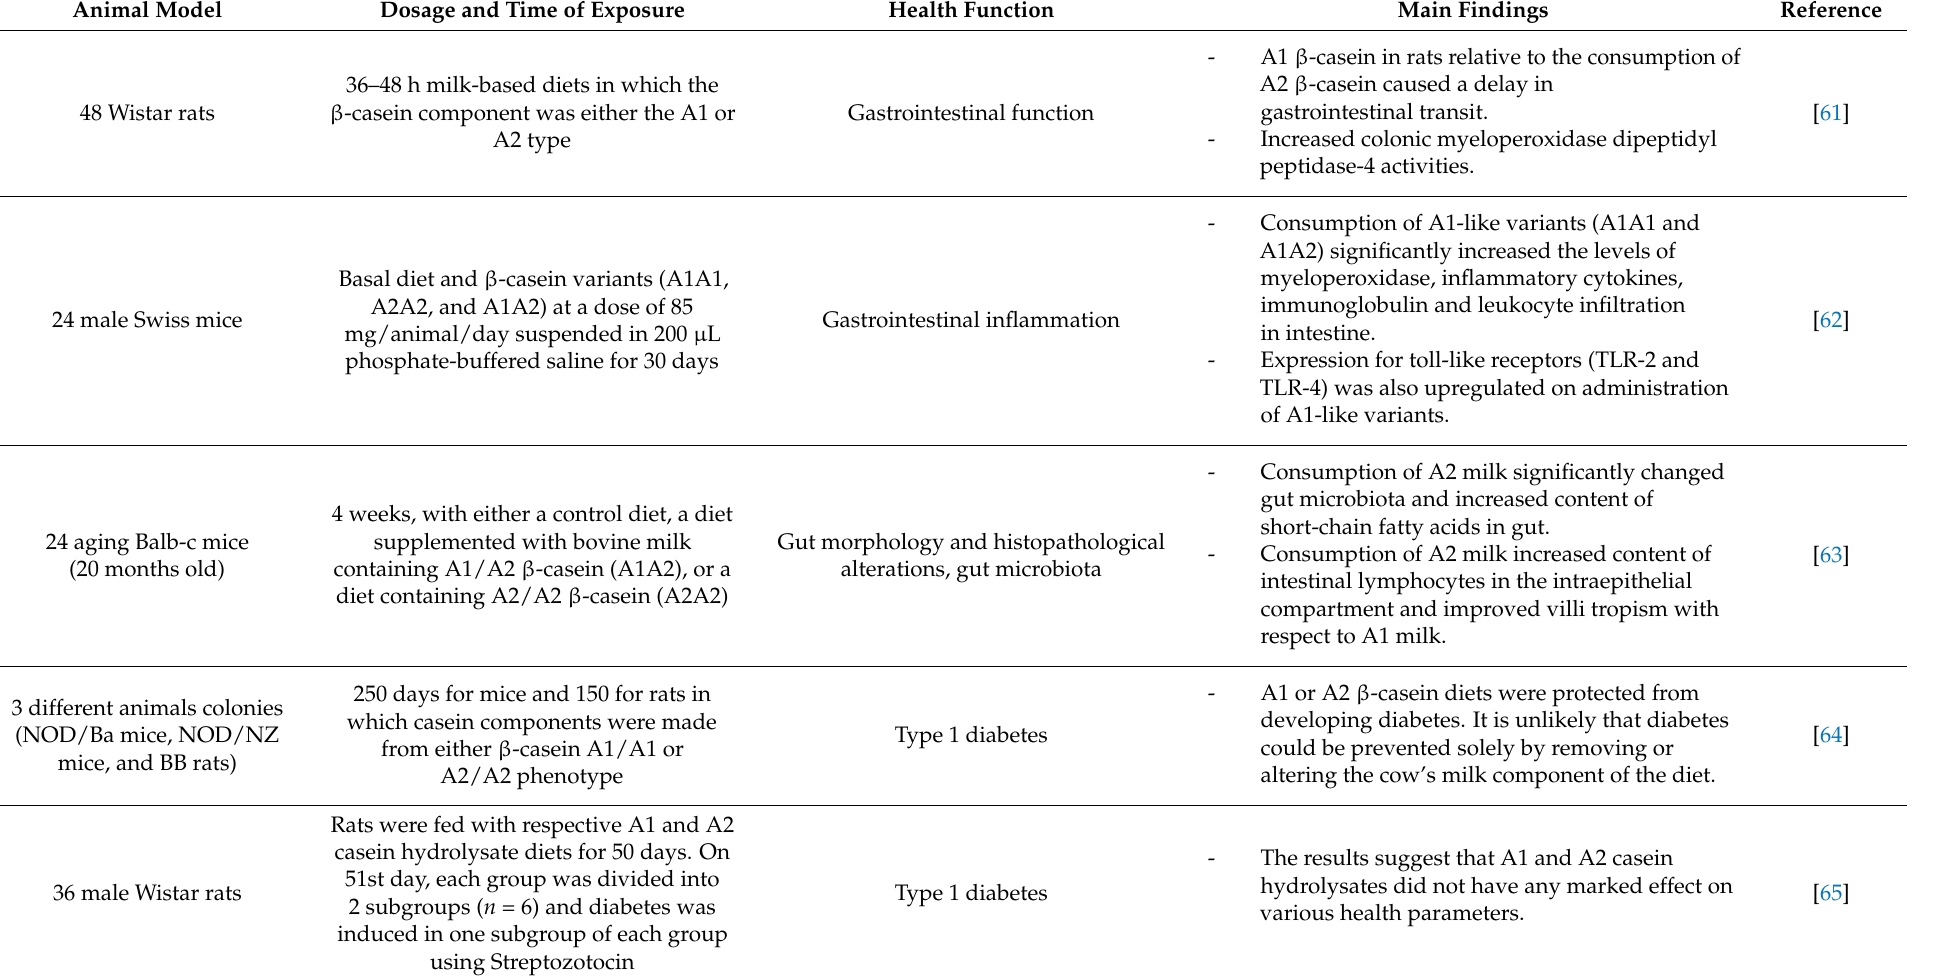
Table 2. Use of A2 milk in experimental animal trials to treat or prevent different health